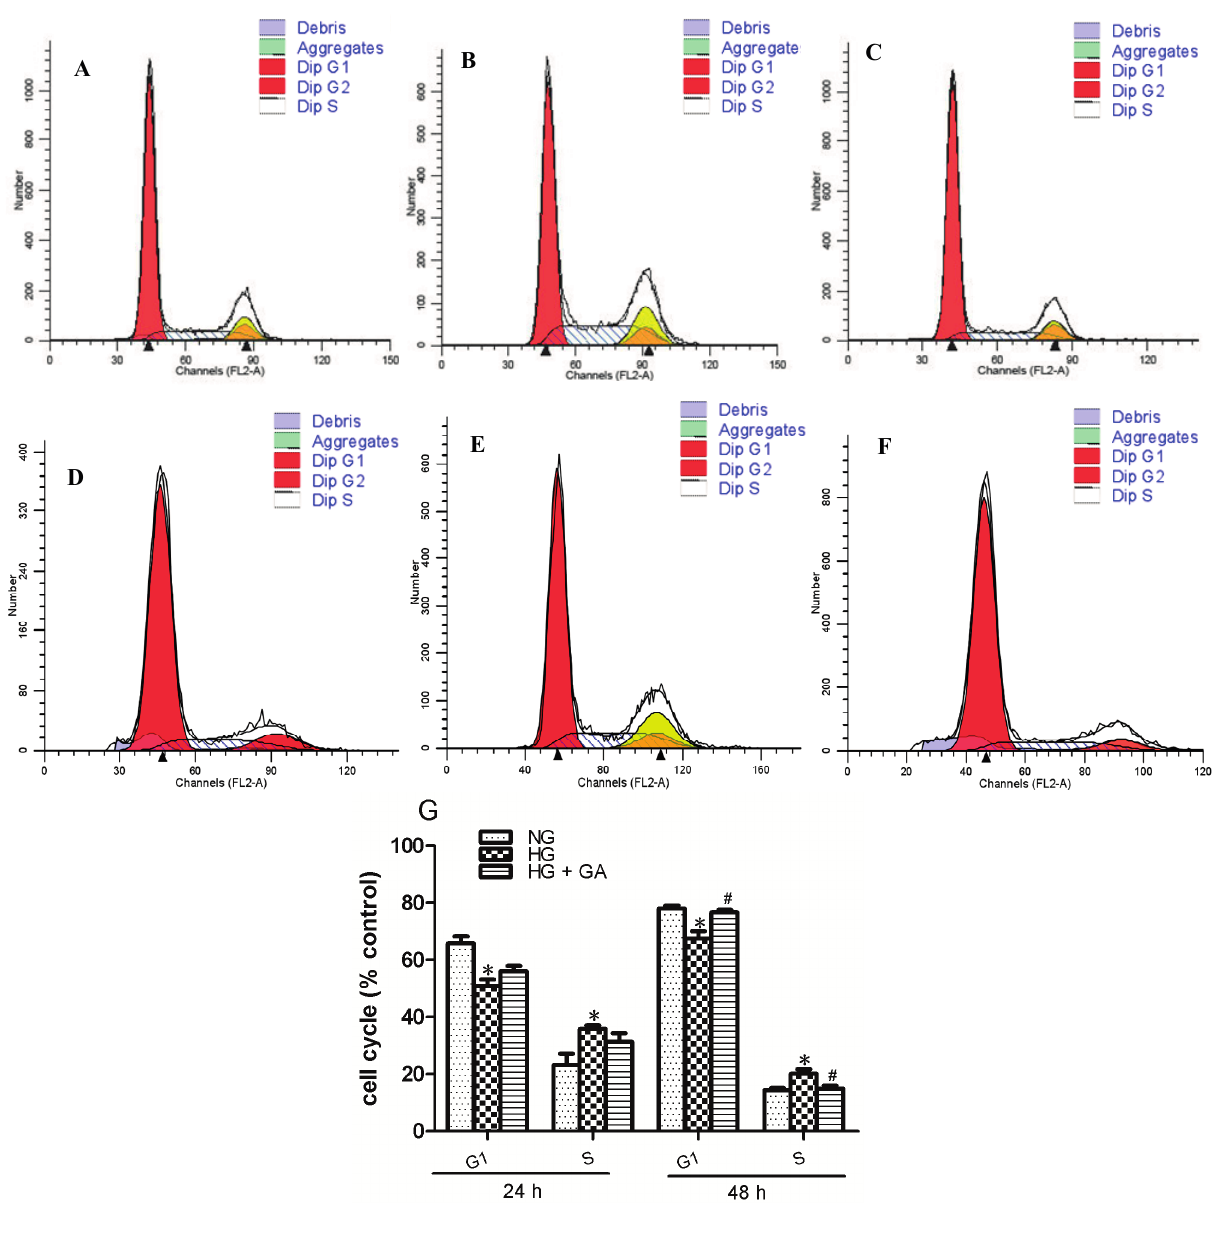
Figure 2. Flow cytometric analysis of the cell cycle. Cells were treated for 24 or 48 h as indicated, ( A ) NG group; ( B ) HG group; ( C ) HG + GA group (treated with 24 h); ( D ) NG group; ( E ) HG group; ( F ) HG + GA group (treated with 48 h); and ( G ) Followed by flow cytometric analysis. * p < 0.05 vs. NG; # p < 0.05 vs.